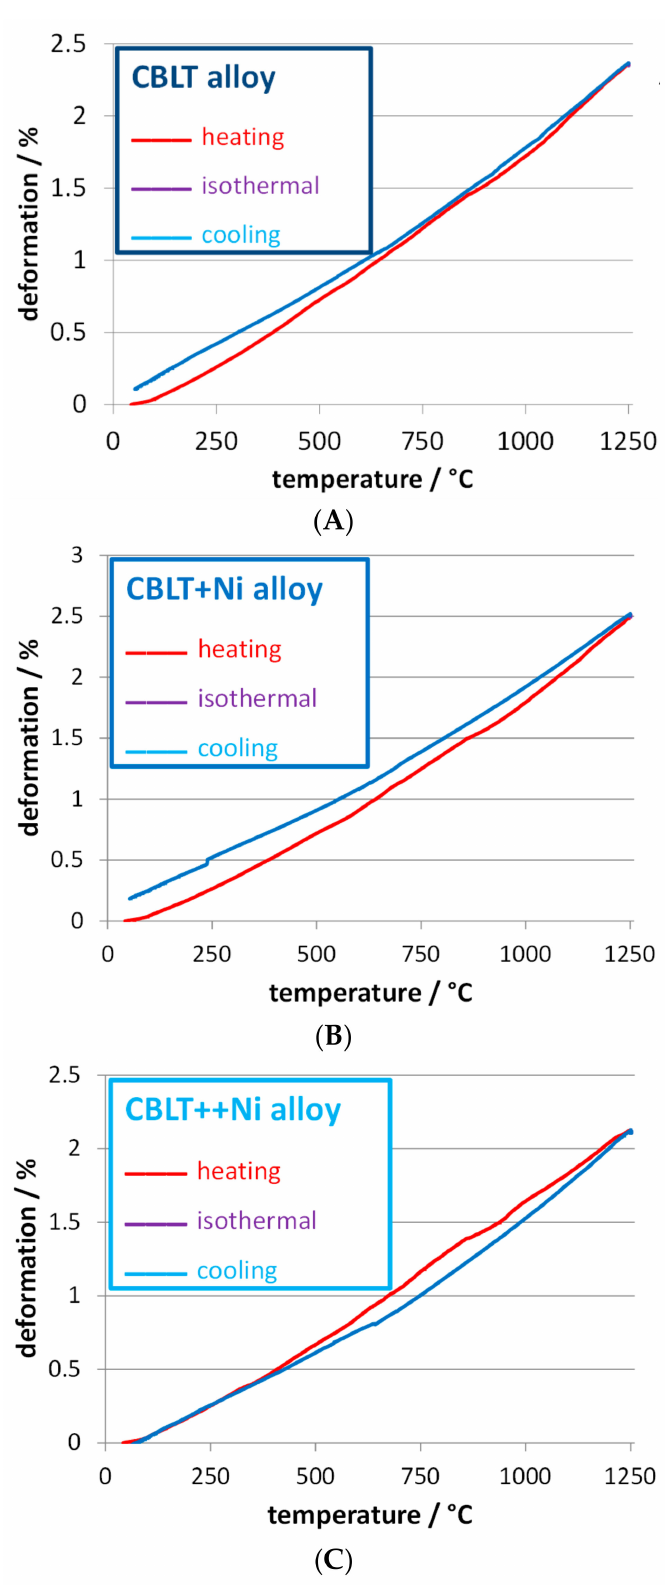
Figure 3. The thermo-mechanical analysis (TMA) curves obtained for three alloys (plotted in the (deformation versus temperature) scheme): ( A ) the CBLT alloy; ( B ) the CBLT+Ni alloy; ( C ) the CBLT++Ni